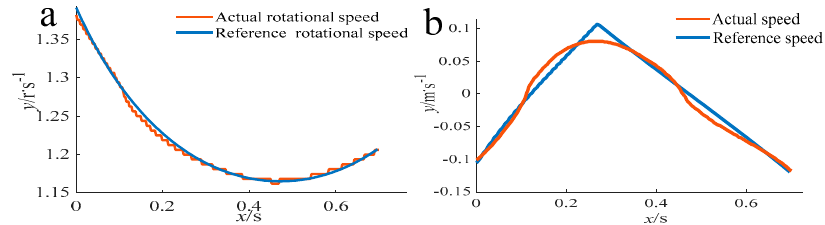
Figure 15. Stepper motor speed contrast. ( a ) Rotational speed of rotating motor; ( b ) speed of sliding table.